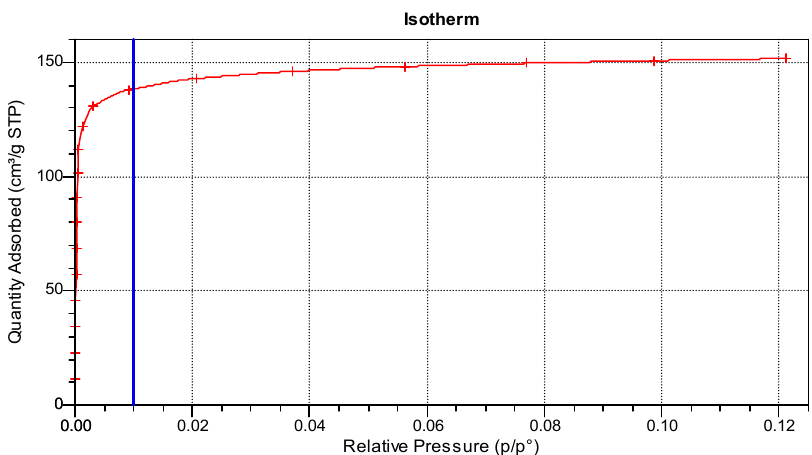
0.000.00 Relative Pressure (p/p°) Energies 2022 , 15 , x FOR PEER REVIEW Figure A1. BET isotherm POR-P20. Figure A1. BET isotherm POR-P20.